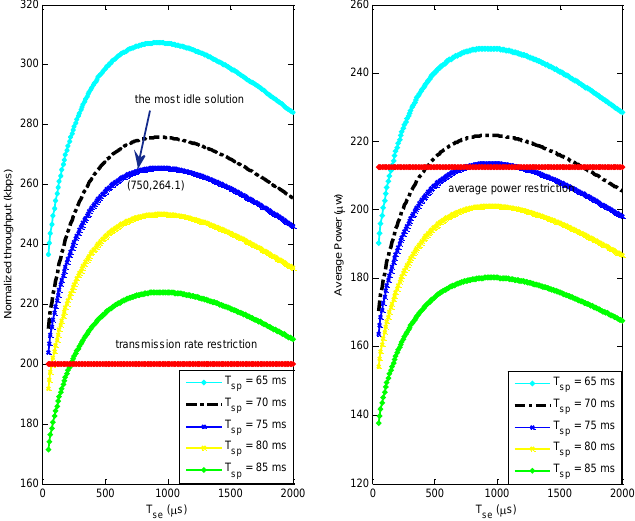
Figure 10. The normalized throughput under different sleeping durations and spectrum sensing durations.